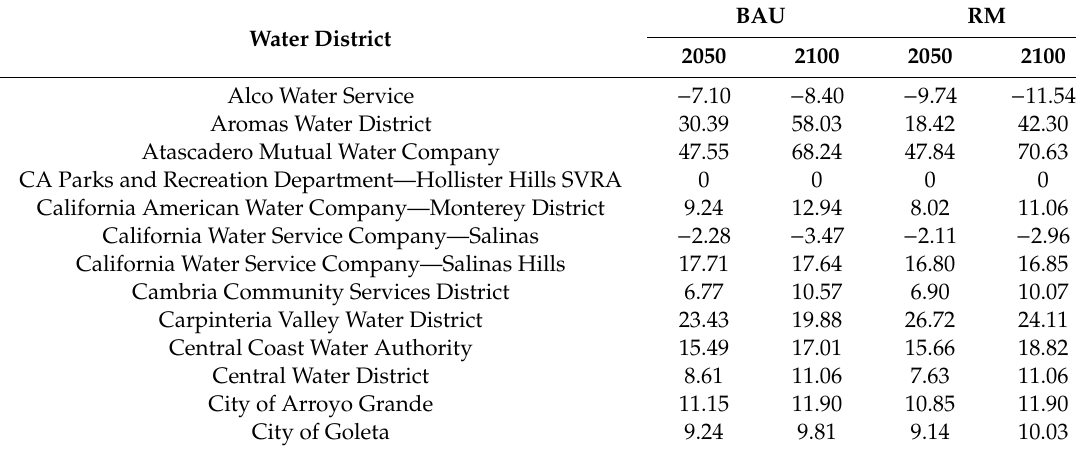
Table 2. Projected percent (%) change in water demand in water districts of the Central Coast (excluding GSAs and county agencies) by 2050 and 2100 under two scenarios, a Business-as-Usual (BAU; fit to 1992–2016 land use change rates) and Recent-Modern (RM; fit to